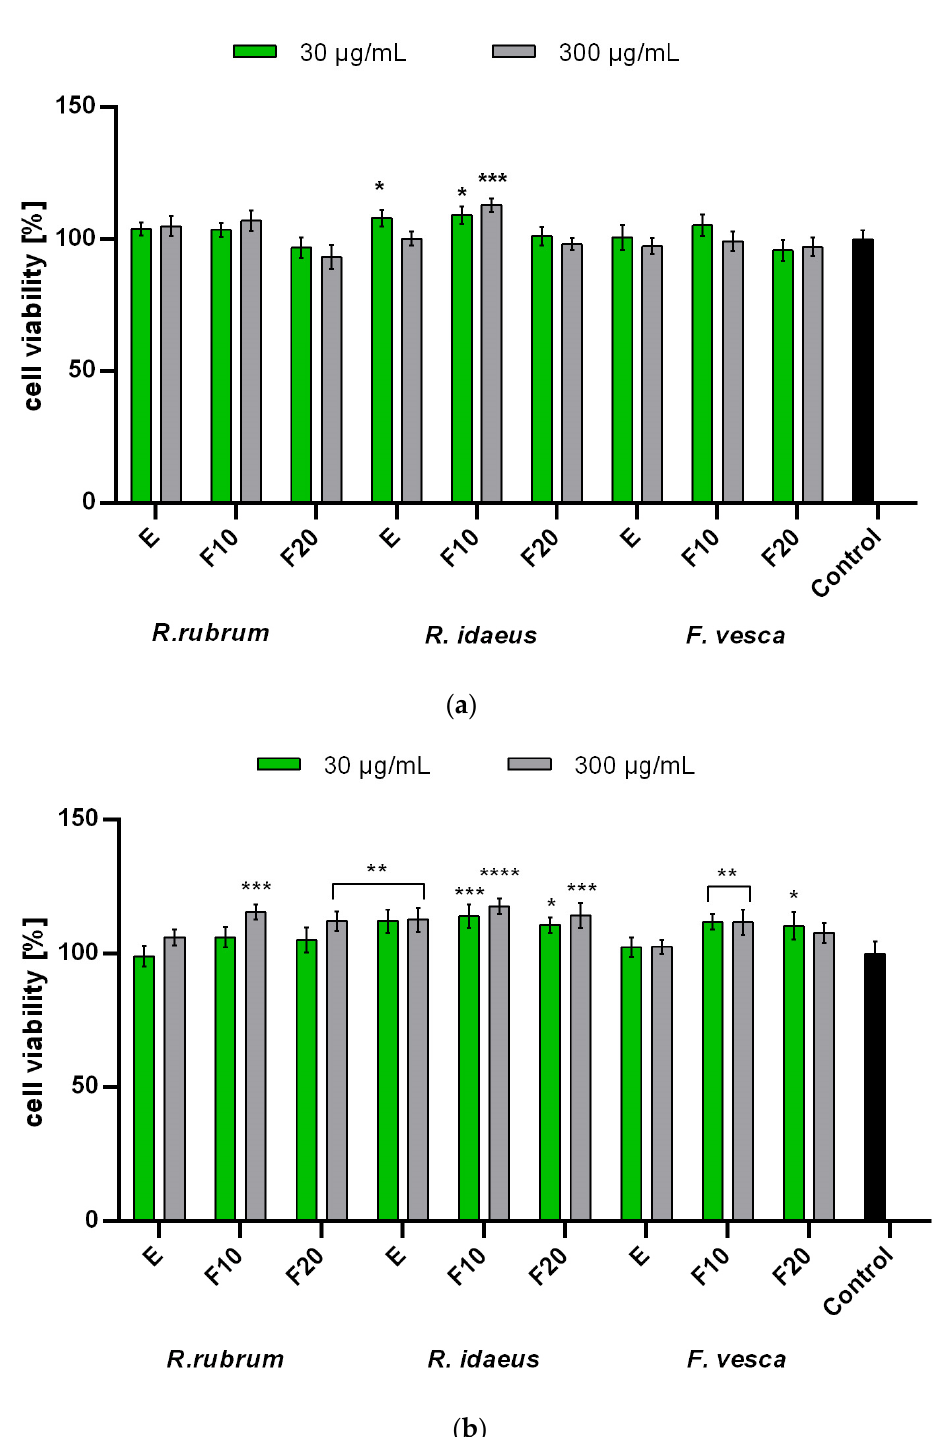
Figure 5. Effect of R. rubrum, R. idaeus, and F. vesca extracts and ferments (at the concentration of 30 and 300 µg/mL) on Alamar Blue Assay ( a ) and Neutral Red dye uptake ( b ) in cultured keratinocytes (HaCaT) after 24 h of exposure. Data are the mean ± SD of three independent experiments, each consisting of three replicates per test group. **** p < 0.0001, *** p < 0.001, ** p < 0.01, * p < 0.05 compared to control.